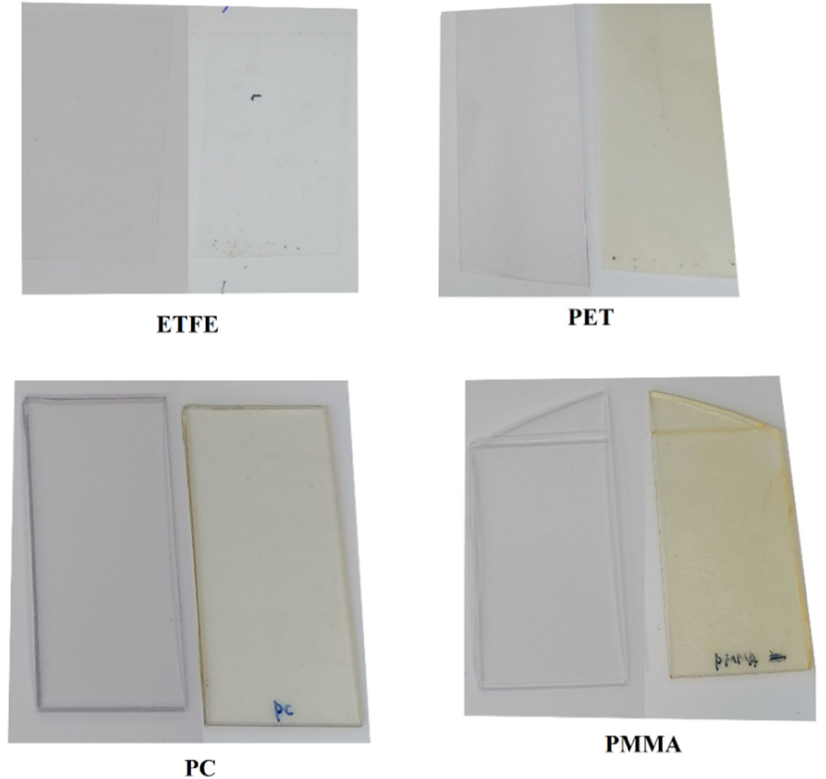
Figure 1. Sample of lightweight front sheets before ( left ) and after ( right ) UV irradiation testing.